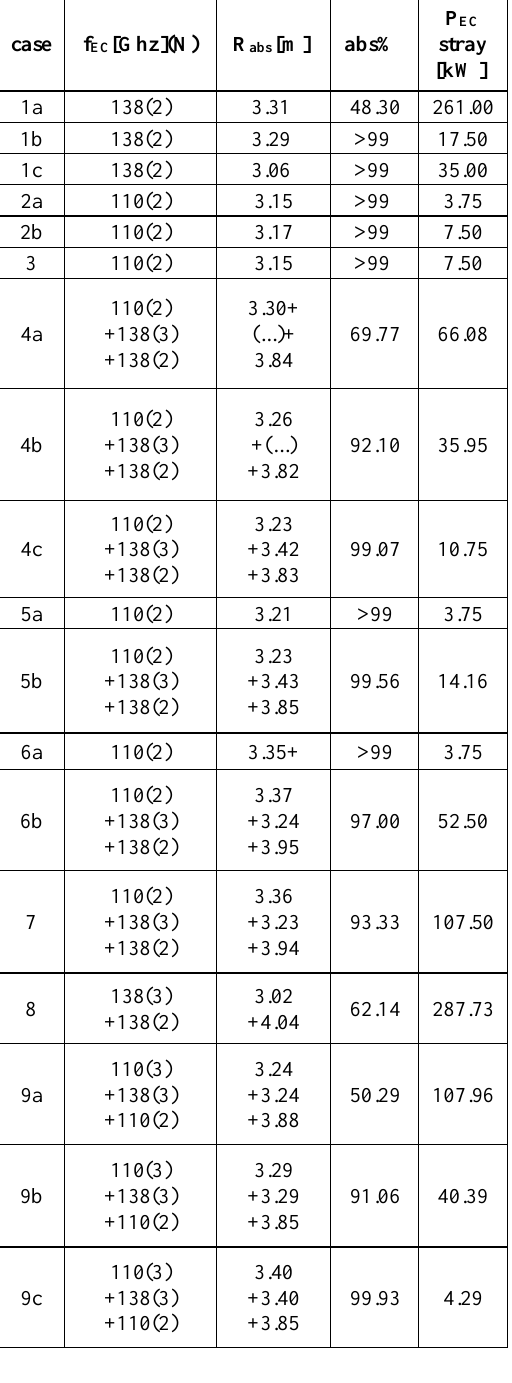
Table 2. EC power stray for the cases of Table 1. Symbol (…) in the R abs means that the absorption corresponding to